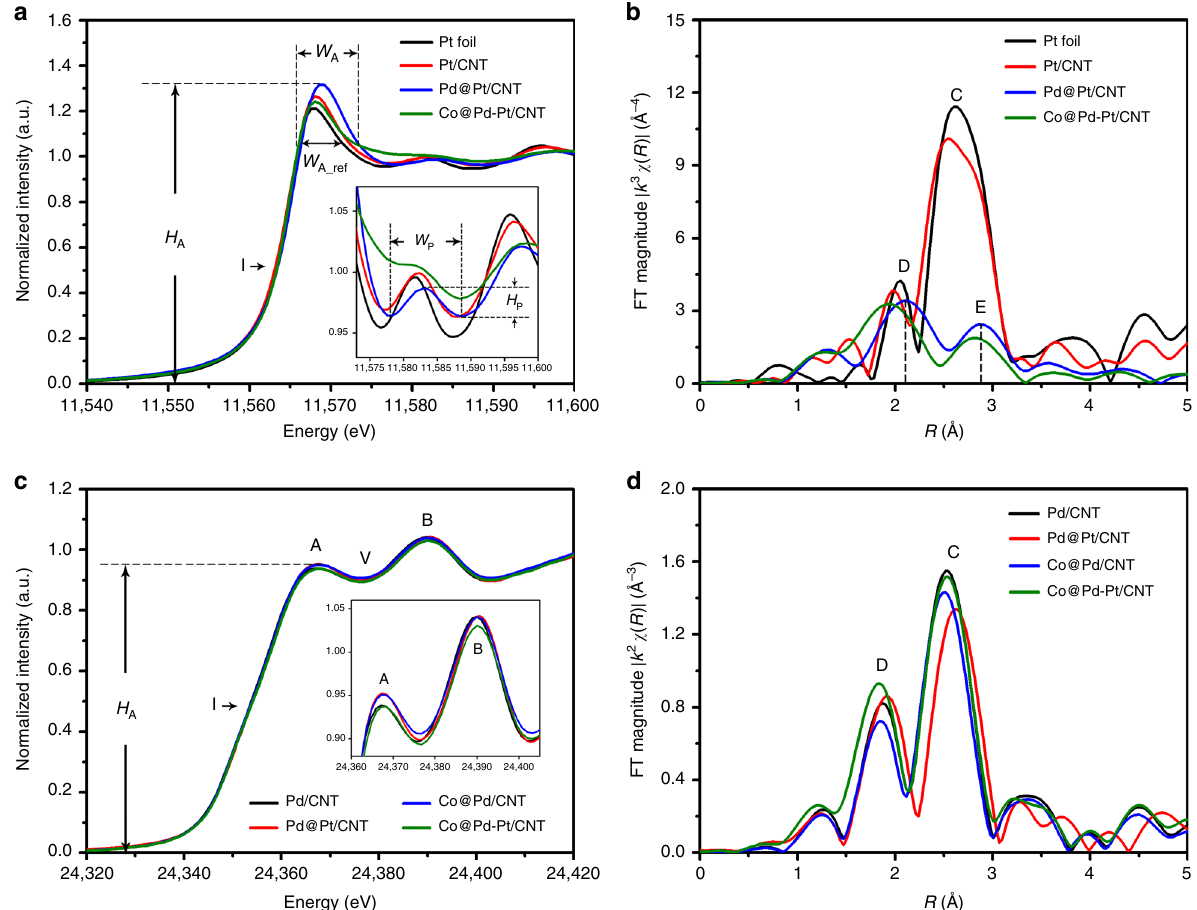
Fig. 2 X-ray absorption spectra of Pt-decorated Co-Pd and control samples. a X-ray absorption near-edge spectra (XANES) of Pt L 3 -edge of standard Pt foil, Pt/carbon nanotube (CNT), Pd-Pt core-shell/CNT (Pd@Pt/CNT), and Pt-decorated Co-Pd/CNT (Co@Pd-Pt/CNT) catalysts. The inset shows the enlarged post-edge region. b Fourier-transformed extended X-ray absorption fi ne structure (FT-EXAFS) of the four samples in a . c XANES spectra of Pd K-edge of Pd/CNT, Pd@Pt/CNT, Co-Pd core-shell/CNT (Co@Pd/CNT), and Co@Pd-Pt/CNT catalysts. The inset shows the enlarged region of peaks A and B. d